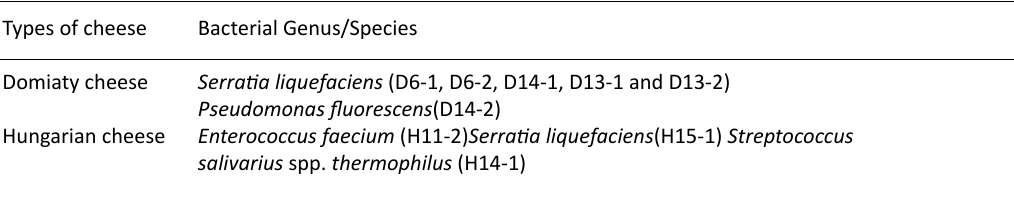
table 6. Identification bacterial genus/species isolated from Domiaty and Hungary cheeses by Vitec MS Types of